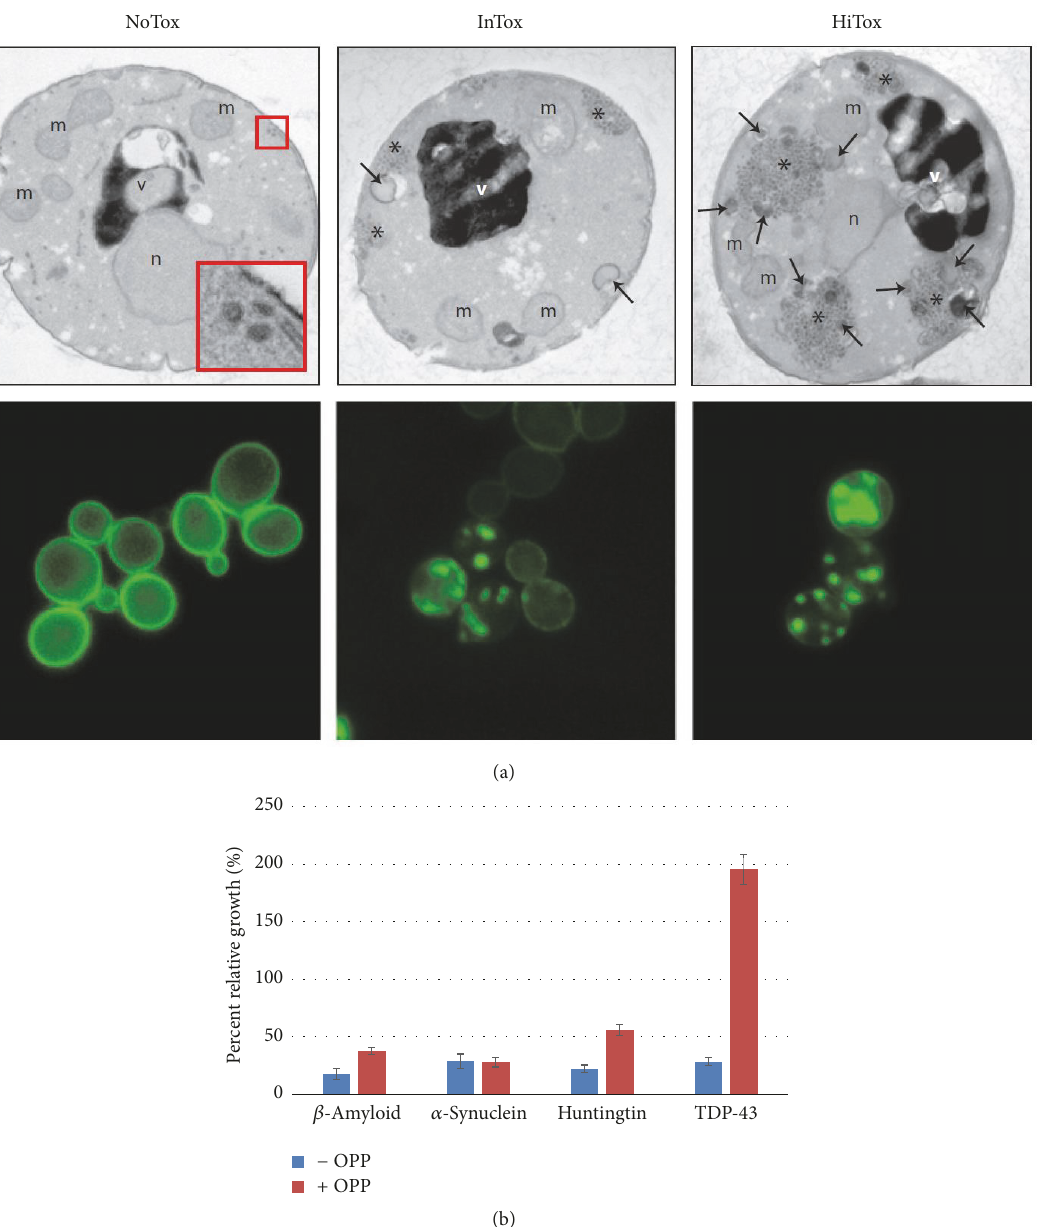
Figure 7: (a) Transgenic yeast which overexpresses the TDP-43 peptide. NoTox = low expression, TDP-43; IntTox = intermediate expression, TDP-43 aggregation seen as clumps of GFP-TDP43; HiTox = high expression, TDP-43 in larger clumps and increased death of yeast. Arrows demarcate the inclusion granules of TDP-43 (Susan Lindquist, MIT). (b) OPP significantly reduces the cytotoxicity of the aggregated neuropeptides in the transgenic yeast rescue assay. Bar heights represent percent growth relative to control strain. OPP doubles the growth for 𝛽 -amyloid-producing yeast from 20% (without OPP) to 40% (with OPP); more than doubles the growth for Huntingtin-producing yeast from 25% (without OPP) to 60% (with OPP). OPP increases the growth of TDP-43-producing yeast more than 6-fold from 25% (without OPP) to 190% (with OPP). There is no significant change in the growth of the 𝛼 -synuclein-producing yeast with or without OPP. OPP dose was 10 𝜇 g/ml for the 4 peptide-producing transgenic